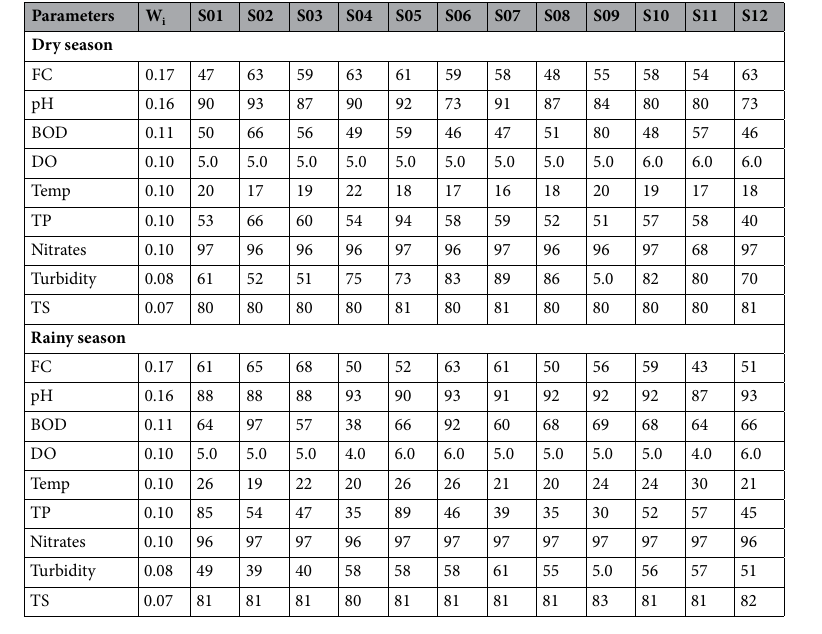
Table 2. Weights and sub-index per each